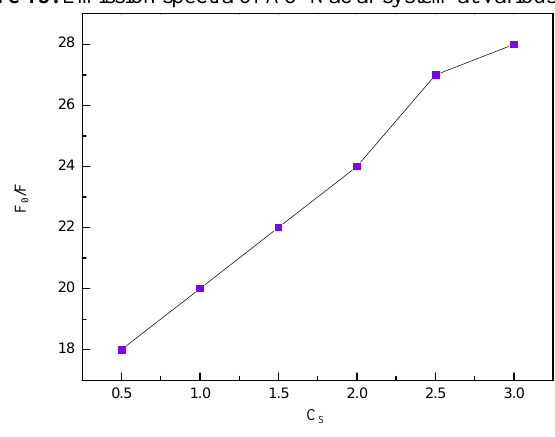
Figure 16. Stern-Volmer plot for AO-NaCar